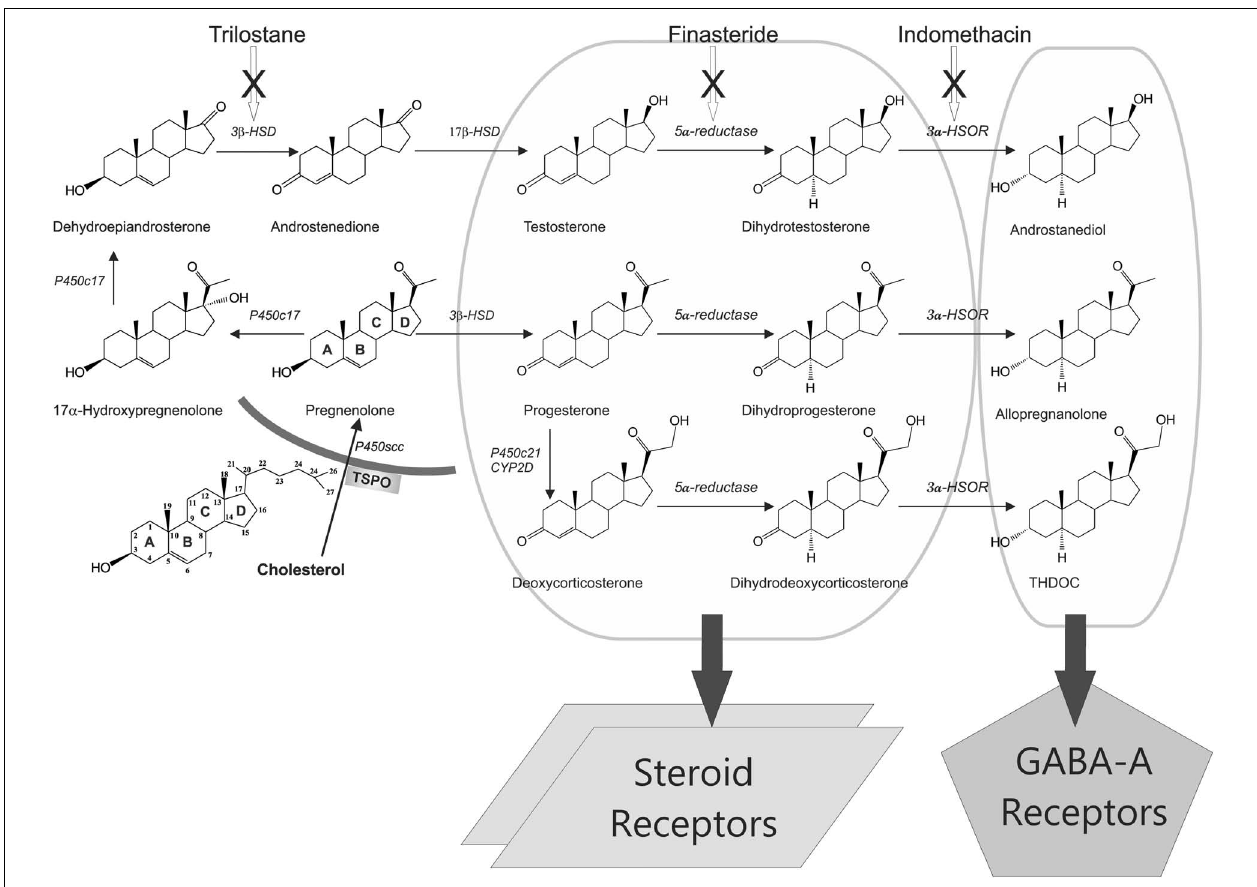
from the pathways, many modifications are made by the same enzymes, which can be blocked by specific inhibitors (trilostane, finasteride, and indomethacin).There are two mechanisms by which steroid hormones affects neuronal function: (i) binding to steroid receptors (PRs, ARs, or MRs; left panel) and (ii) conversion to GABA-A receptor-modulating neurosteroids (right panel). Progesterone, deoxycorticosterone, or testosterone binding to their cognate steroid receptors could lead to activation of gene expression in the brain. Neurosteroids rapidly modulate neuronal excitability by direct interaction with inhibitory GABA-A receptors in the